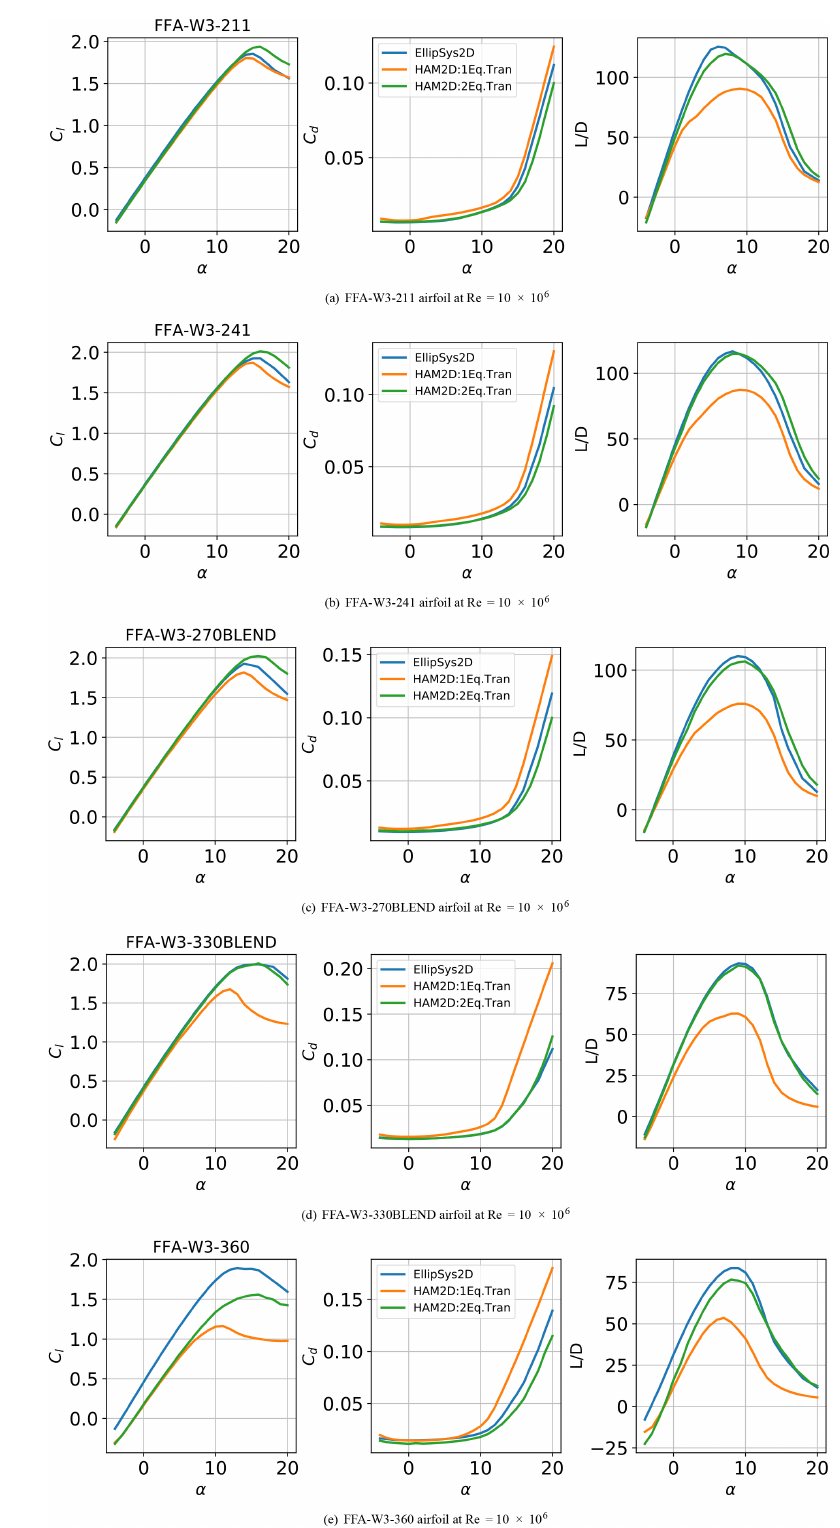
Figure A2. Aerodynamic coefficient polars for the FFA airfoil series using fully turbulent and free-transition results at Re = 10 × 10 6 generated using HAM2D compared against a mix of 70% transition and 30% turbulent data from EllipSys2D (Gaertner et al., 2020).